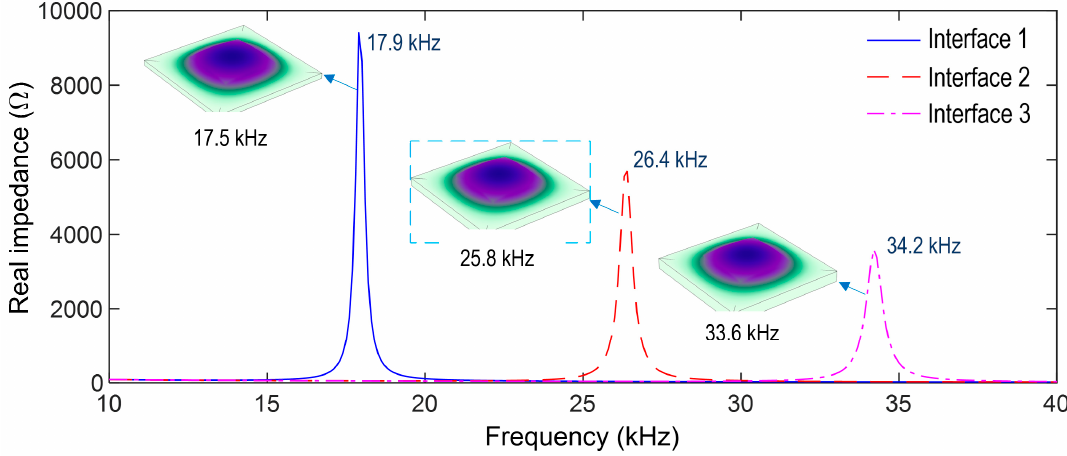
Figure 6. Impedance peaks and corresponding eigen-modes of three PZT interfaces.